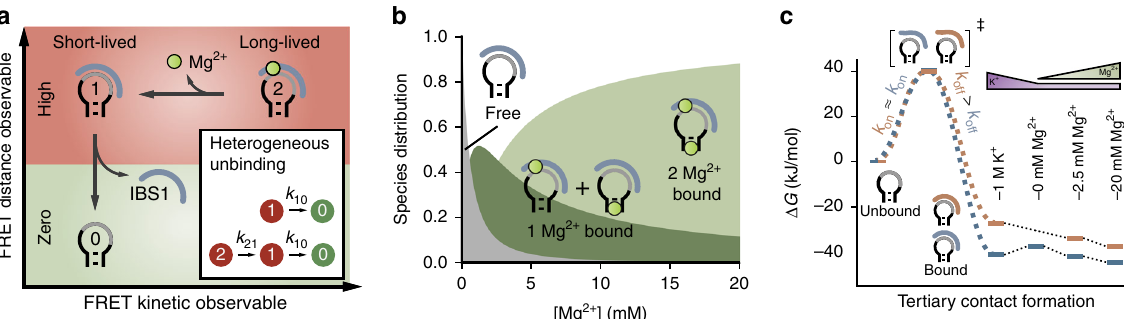
Fig. 5 Tertiary contact formation monitored by FRET in space and time. a Exon release is described by two FRET observables: dye distance and state dwell times. Intron – exon dissociation can occur from state 1 (Mg 2 + free) or state 2 (Mg 2 + bound) and is thus kinetically heterogeneous. b Occupation of Mg 2 + binding sites as a function of the ion concentration using Mg 2 + binding constants from NMR chemical shift perturbations (Eq. 5) 15 . Cartoons depict possible species with no (gray), one (dark green), or two Mg 2 + bound (light green). The Mg 2 + free species corresponds to the high FRET state 1 in a , while the other species together make up state 2. Diffuse Mg 2 + ions are omitted for clarity. c Free energy diagram of tertiary contact formation featuring a reactant-like, unstructured transition state. Off-rates determine the stability of the interactions. Dotted black lines connect levels of the bound state at different metal ion concentrations. Source data are provided as a Source Data fi